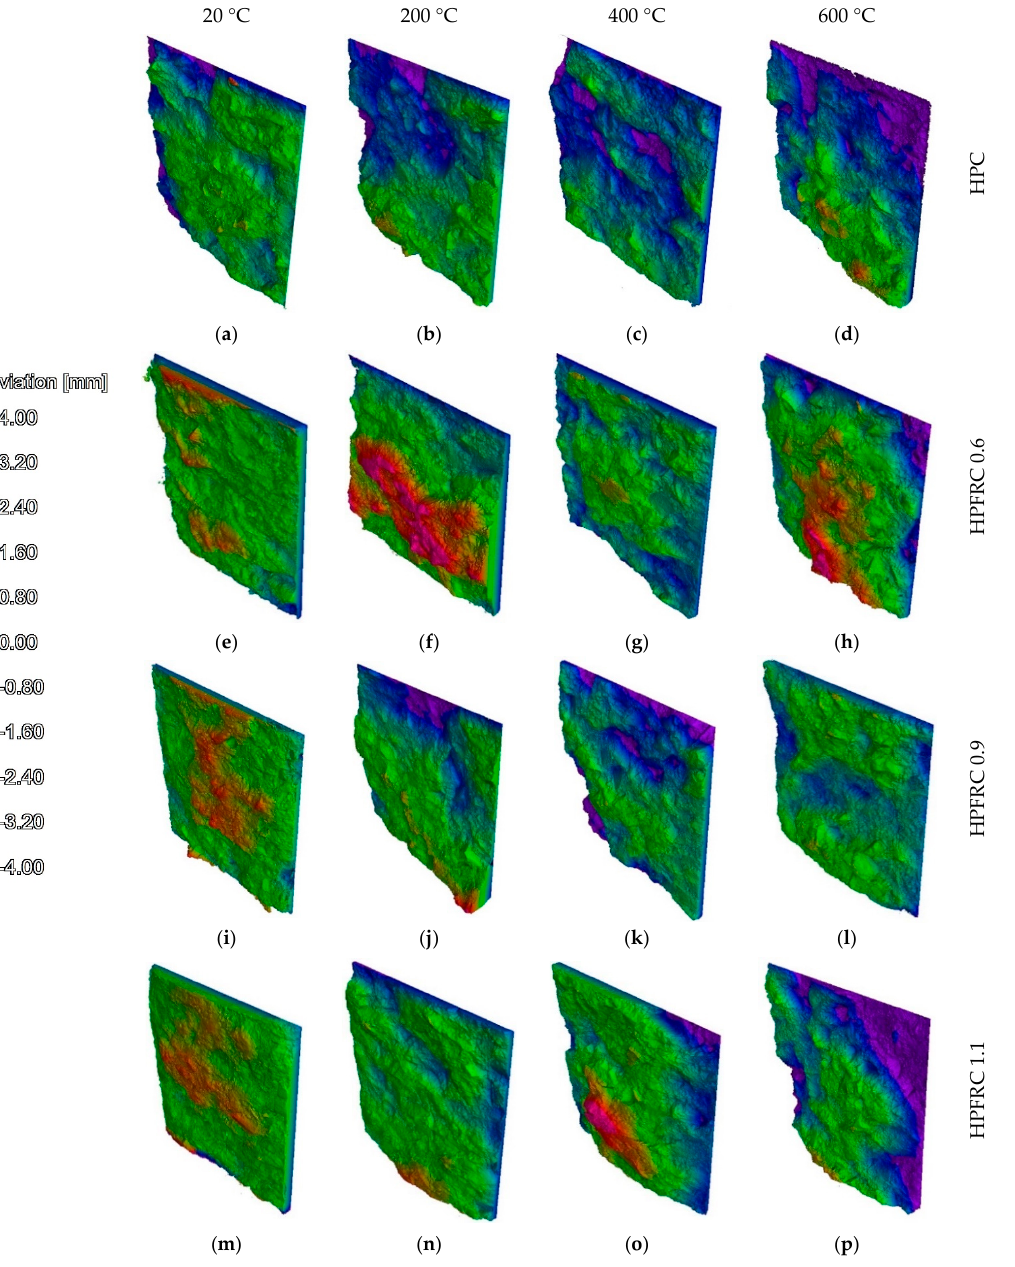
Figure 9. Map of surface deviations after tensile by splitting tests from a hypothetical plane based on vertical diameter: ( a ) HPC 20 ◦ C; ( b ) HPC 200 ◦ C; ( c ) HPC 400 ◦ C; ( d ) HPC 600 ◦ C; ( e ) HPFRC 0.6 20 ◦ C; ( f ) HPFRC 0.6 200 ◦ C; ( g ) HPFRC 0.6 400 ◦ C; ( h ) HPFRC 0.6 600 ◦ C; ( i ) HPFRC 0.9 20 ◦ C; ( j ) HPFRC 0.9 200 ◦ C; ( k ) HPFRC 0.9 400 ◦ C; ( l ) HPFRC 0.9 600 ◦ C; ( m ) HPFRC 1.1 20 ◦ C; ( n ) HPFRC 1.1 200 ◦ C; ( o ) HPFRC 1.1 400 ◦ C; ( p ) HPFRC 1.1 600 ◦